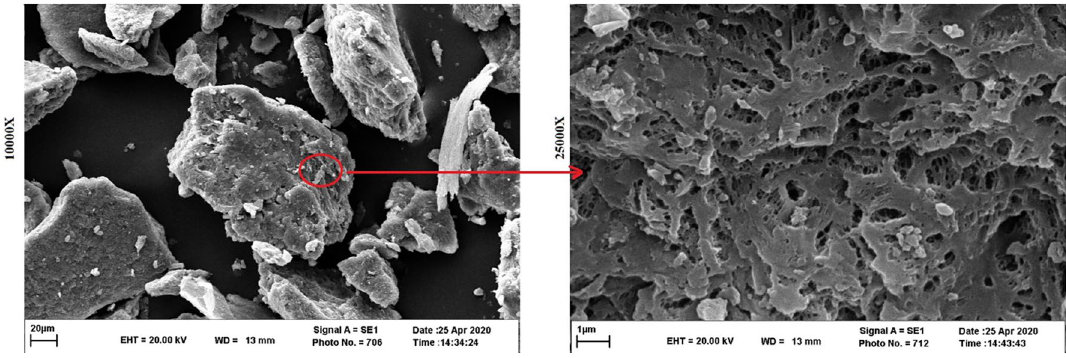
Fig. 2 SEM Images of S. Platensis Table 2 Surface and pore characteristics of S. platensis Mean pore diameter (nm)